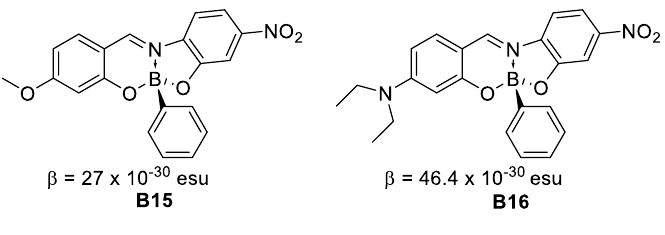
Figure 14. “ Push-pull” boronates.